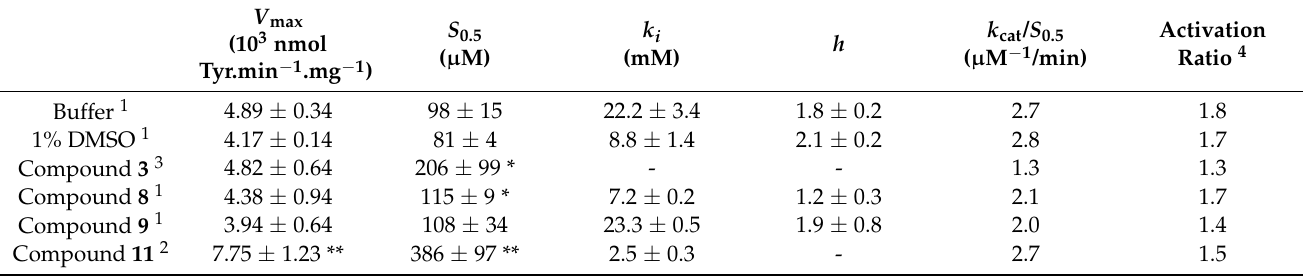
Table 1. Steady-state kinetic parameters of human phenylalanine hydroxylase (hPAH) for the substrate ( L -Phe) in the absence and presence of 100 µ M of selected